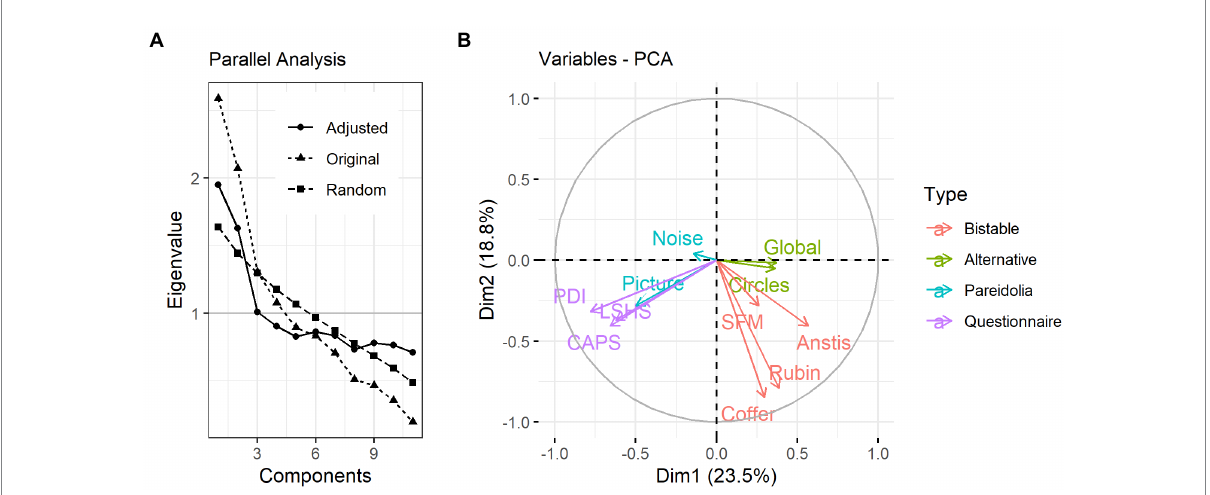
FIGURE 5 PCA results. (A) Parallel analysis result showing the original, random and adjusted eigenvalues for each component. According to the parallel analysis, the first 3 components are the most relevant for explaining variance in the data. (B) Biplot showing the distribution of the variables across the first two principal components. Length of an arrow represents its contribution to the respective component, while the angle between each two arrows represents the degree of association between variable pairs (the smaller the angle, the stronger the association).